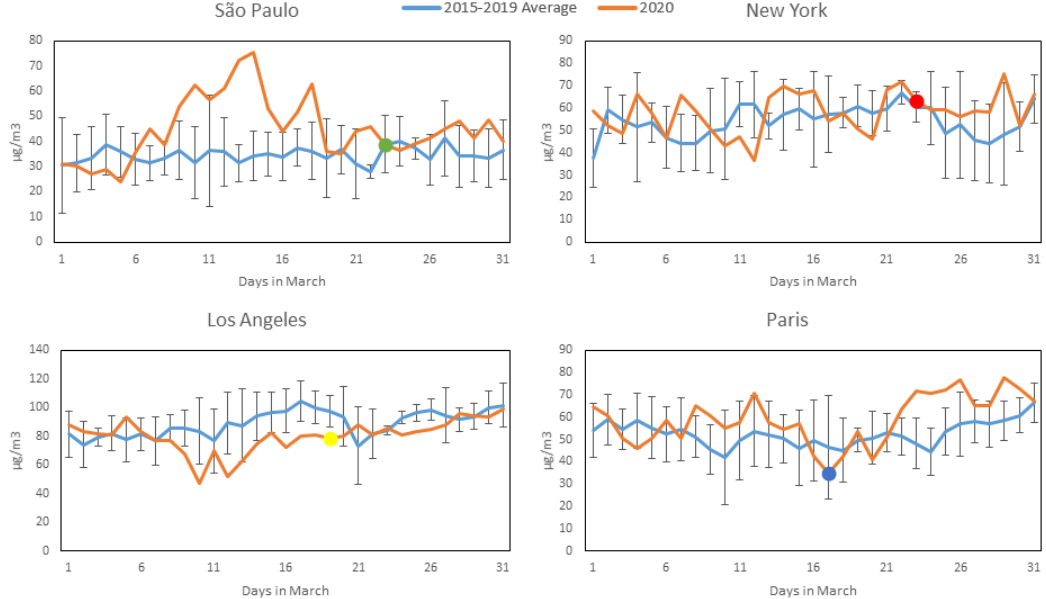
Figure 4. O 3 concentration profiles during March 2020 (Orange) compared to average and standard deviation of March concentrations over the previous 5 years (Blue) for the four studied cities (most significant COVID-19 intervention date indicated with colored dot). All available station data used for each city (see Section 2.2).